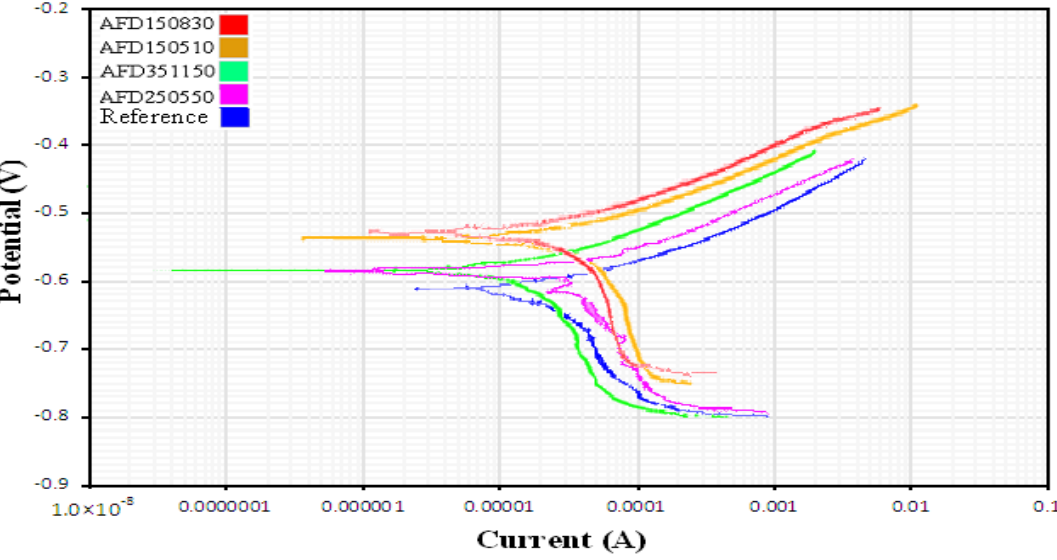
Figure 16. Polarization curves of specimens.